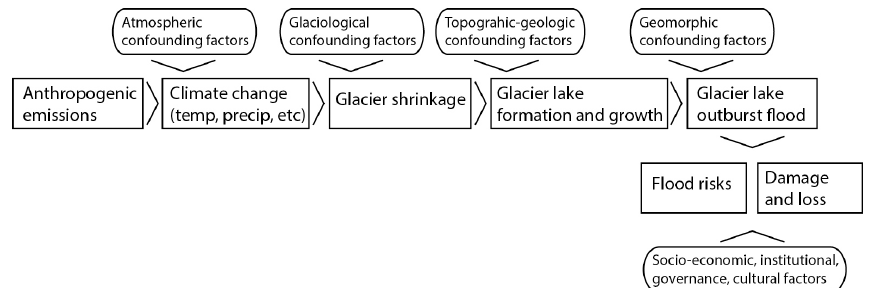
Figure 4. Causation chain from anthropogenic emissions to glacier lake flood risk. At each element of the causation chain non-climatic (confounding) factors are indicated, which also influence the respective